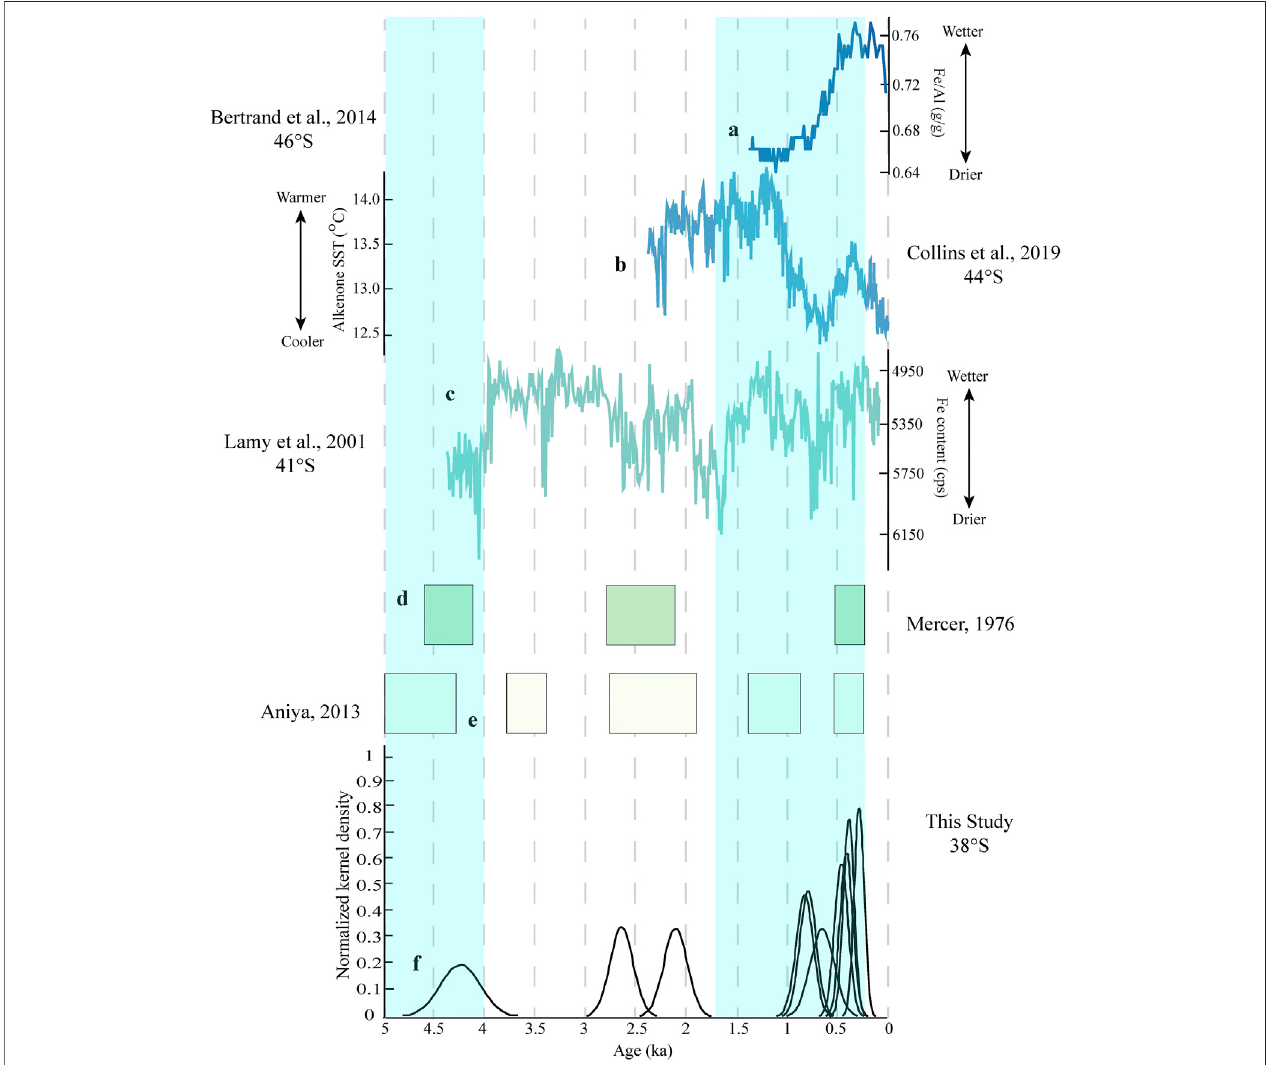
FIGURE 8 | From top to bottom: (A) Ratio of Iron (Fe) to Aluminum (Al) (g/g) from sediment core PC29A retrieved from Quitralco fjord (46 ° S), as a proxy for precipitation seasonality. An increase in Fe/Al is interpreted as increased precipitation regionally due to latitudinal variations in the position of the SWWB (Bertrand et al., 2014). (B) An alkenone based proxy record for SST ( ° C) from oceanic sediment core MD07-3093 (44 ° S) (Collins et al., 2019). (C) Iron (Fe) intensity (cps) from oceanic sediment core GeoB 3313-1 (41 ° S), as a proxy for position of the SWWB. Decreased Fe intensity is interpreted as the SWWB located in a more northerly position compared to the study location, resulting in wetter conditions regionally (Lamy et al., 2001). (D) Timing of “ Mercer-type ” glaciations in Southern Chile (Mercer, 1976). (E) Timingof “ Aniya-type ” glaciationsinSouthernChile(Aniya,2013). (F) Chlorine-36surfaceexposureagesfromthisstudy.Blueverticalbarsindicateassessedintervalsof SAM negative phases (cold and wet), inferred from the Lago Cipreses sediment core record (51 ° S) (Moreno et al., 2018).